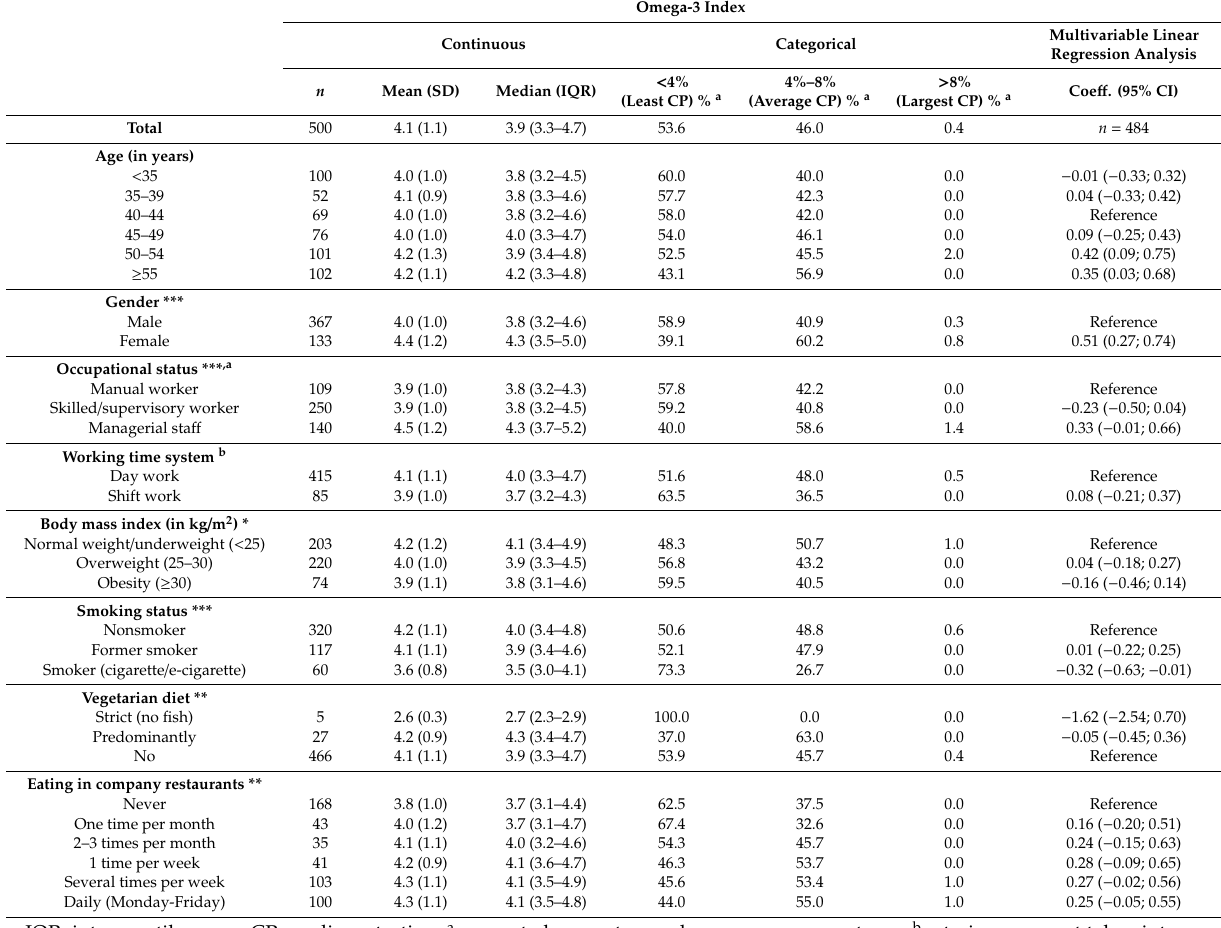
Table 3. Omega-3 index (categorical and continuous) stratified according to selected sociodemographic, occupational and lifestyle-related factors ( n =